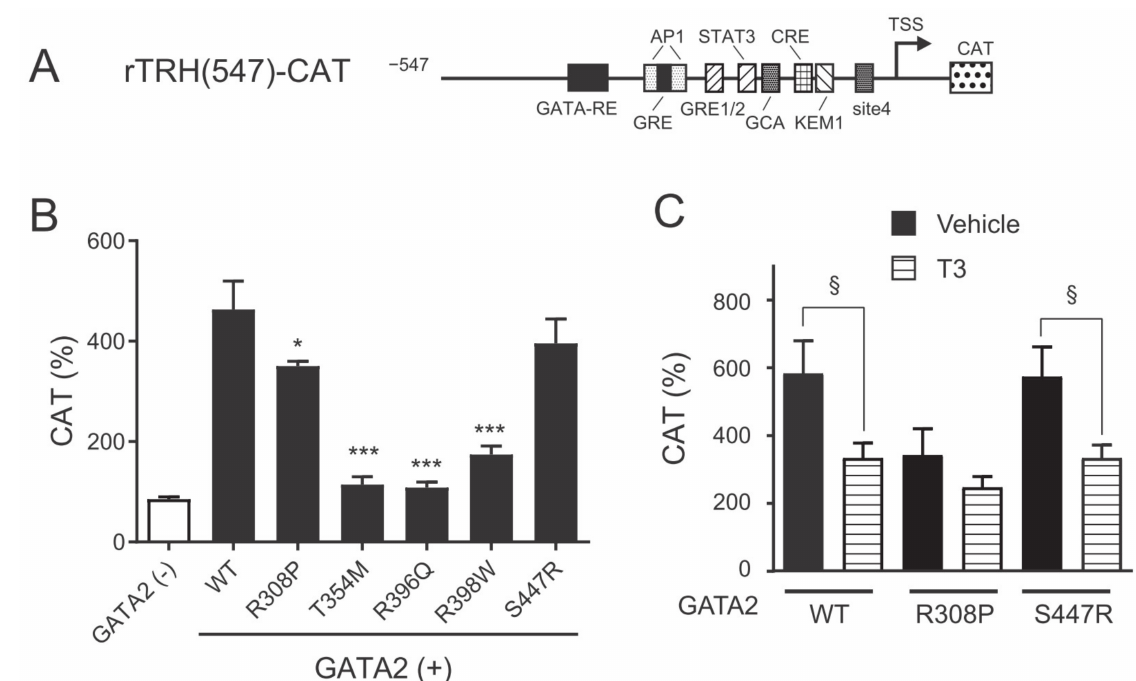
Figure 2. GATA2 mutations impair basal preproTRH transcriptional activity. ( A ) Schematic representation of rTRH(547)- CAT. GATA-RE; GATA responsive element; AP-1, AP-1-binding site; GRE, glucocorticoid responsive element; GRE1/2, glucocorticoid responsive element half-site; STAT, signal transducer and activator of transcription; CRE, cyclic AMP response element; GCA, GCA site; KEM1, KEM1 site; TSS, transcription start site; CAT, chloramphenicol acetyltransferase. ( B ) and ( C ) rTRH(547)-CAT (1.0 µ g) was transfected into CV1 cells along with expression plasmids for various GATA2 mutants (0.1 µ g), TR β 2 (0.1 µ g), and pCMV- β -galactosidase (0.2 µ g). After 24 h of culture, the cells were treated with vehicle or 10 nM T 3 for an additional 24 h. CAT activity was normalized with β -galactosidase activity. CAT activity for pCMV-CAT (5 ng/well) was taken as 100%. Data are expressed as the mean ± S.E. of at least three independent experiments. * p <